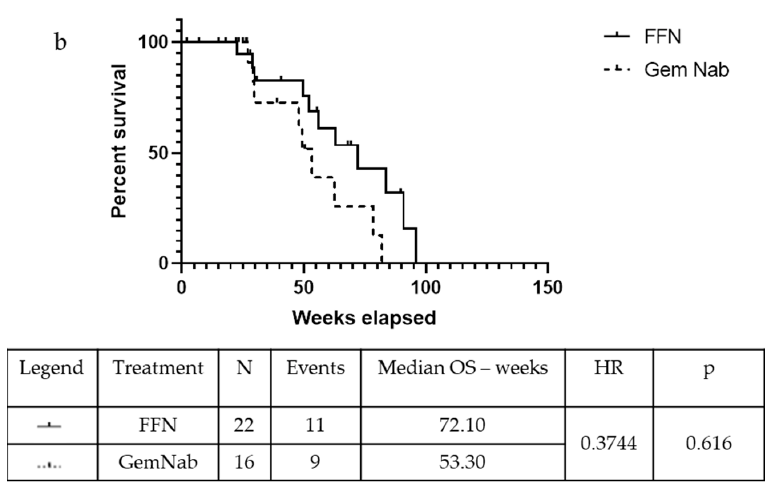
Figure 3. Kaplan-Meyer curve for OS (a) and PFS (b) of patients not undergoing surgery in FFN and GemNab groups. (a) Kaplan-Meyer curve for OS of patients not undergoing surgery in FFN and GemNab groups. In the unresected population, the mOS was 72.10 weeks in the FFN group and 53.30 weeks in the patients treated with GemNab: although not statistically significant, there is a positive tendency in favour of FFN treatment ( p = 0.06, 95% C.I. 0.13–1.05; HR = 0.37). (b) Kaplan-Meyer curve for PFS of patients not undergoing surgery in FFN and GemNab groups. The median Progression Free Survival (mPFS) was 49.40 weeks in the FFN unresected group and 30.90 weeks in the GemNab unresected group ( p = 0.0029, 95% C.I. 0.131–0.863; HR = 0.35).